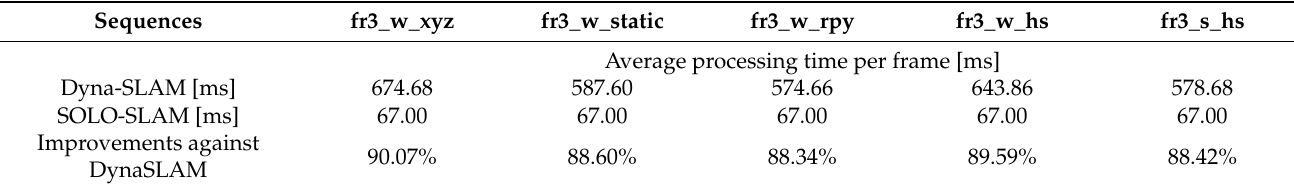
Table 5. Comparison of Dyna-SLAM and SOLO-SLAM processing